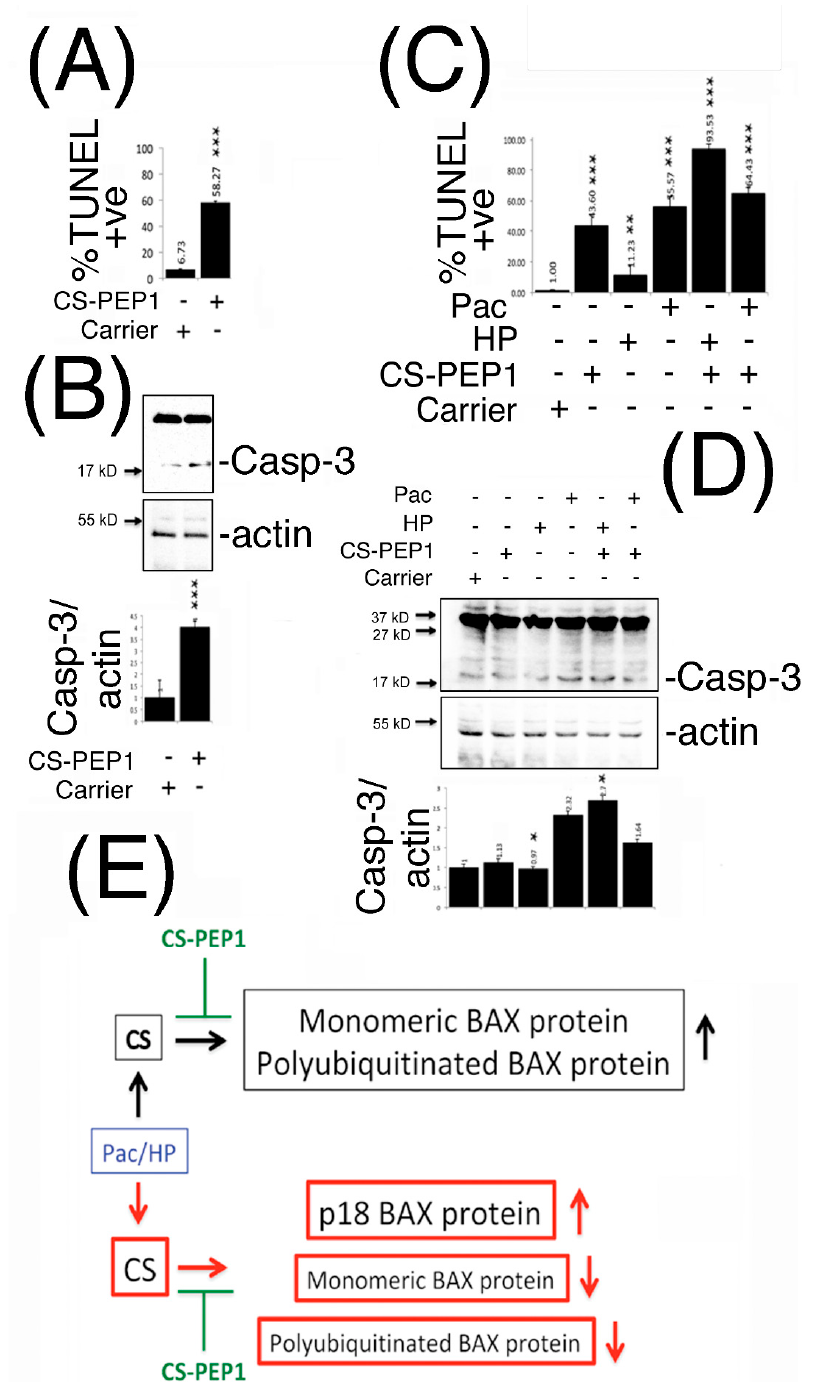
Figure 7. CS-PEP1 enhances apoptosis of HEK293 and 769P cells through enhanced caspase-3 activation, and interferes with a novel CS-mediated regulatory paradigm for the BAX protein. HEK293 (Panel A ) or 769P cells (Panel C ) were respectively co-stimulated with CS-PEP1 (10 µ M), HP (5 µ M) or Pac (5 µ g/mL) for 24 h and apoptotic cells quantified after TUNEL staining. Equal volumes of soluble whole cell lysates (WCLs) prepared from cells treated identically as in Panels A and C were analyzed for active caspase-3 (Casp-3) and actin expression (Panels B and D ). Expression levels of active caspase-3 were quantified and standardized for actin expression in relation to cell stimulated with carrier alone (Panels B and D , lower panels). (Panel E ), At basal cathepsin S protein expression levels, BAX protein predominantly exists as a monomeric p21 form and which can undergo polyubiquitination-mediated destabilization (black boxes). Under Pac- and